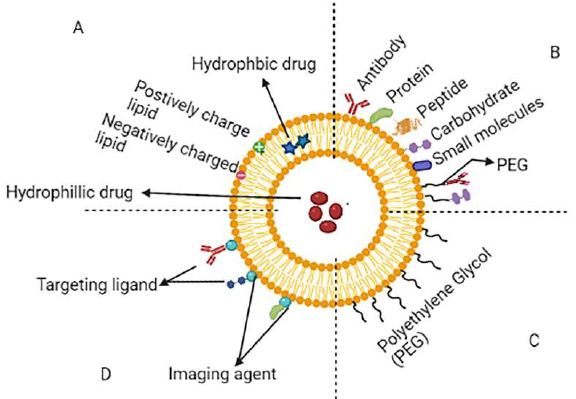
Figure 2. Schematic representation of different types of liposomes. ( A ) Conventional liposome, ( B ) ligand targeted liposome, ( C ) PEGylated liposome and ( D ) theranostic liposome.